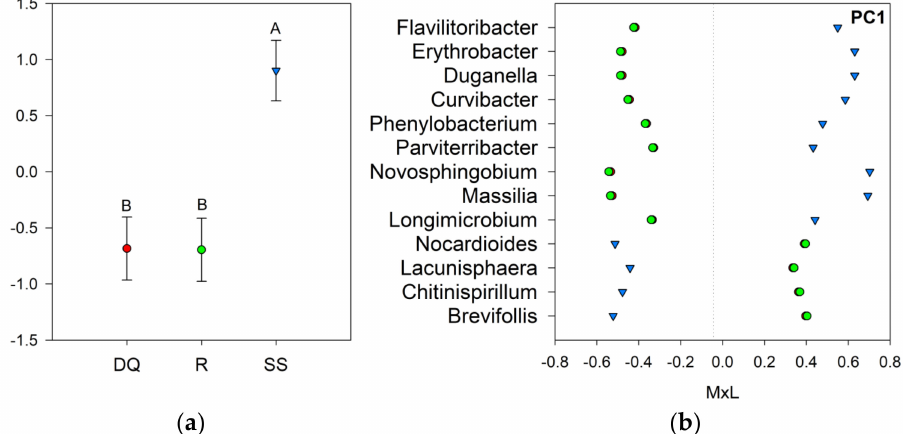
Figure 3. Visual representation of the combined results of the principal component analyses (PCAs) and their mean separation procedure showing the genera with loadings >|0.45| according to Supplementary Table S3 for PC1: ( a ) Mean values of the PC1 scores for each suppression method with their standard errors (as error bars). Different capital letters indicate significant differences between suppression methods ( p < 0.05); ( b ) Contribution of each indicator genera to the PC1 mean value (Table 4) for each suppression method (DQ, red circles: chemical suppression; R, green circles: rolling, and SS, blue triangles: no suppression) multiplied by the loading of the specific genera within the PC (Table S3), named M ×